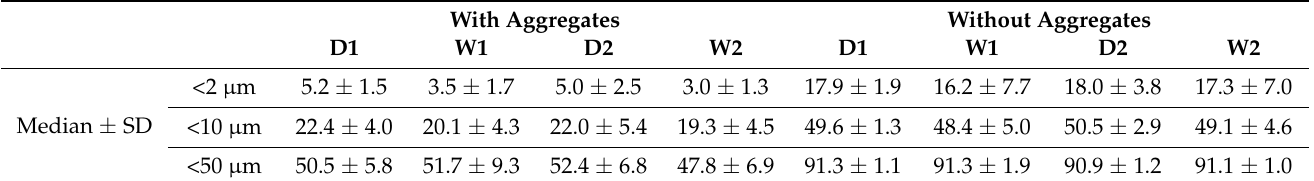
Table 3. Statistical analysis (median and standard deviation) of influence of initial conditions to the particle size distribution (obtained by LD) for the samples from the plot with slope 22 ◦ [%]. With Aggregates Without Aggregates D1